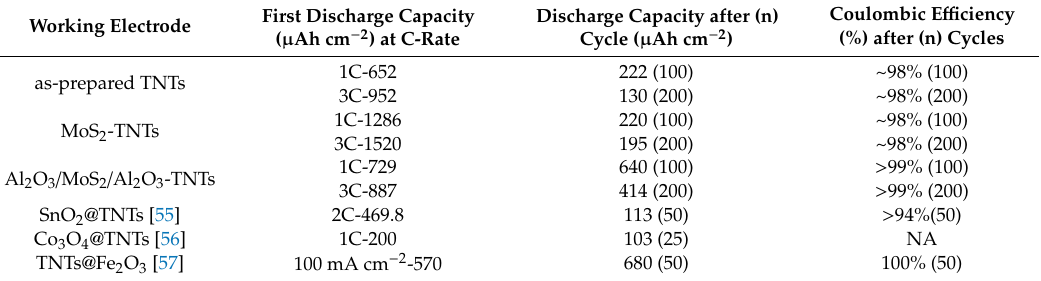
Figure 5. Long-term cycling tests of as-prepared TNTs, MoS 2 -TNTs, and Al 2 O 3 / MoS 2 / Al 2 O 3 -TNTs: ( a ) at 1C for 100 cycles, and ( b ) the corresponding coulombic efficiency vs . cycle number and ( c ) at 3C for 200 cycles. Table 1. Comparison of the electrochemical performance of as-prepared and atomic layer deposition (ALD)-decorated TNTs with TNTs coated with various materials.